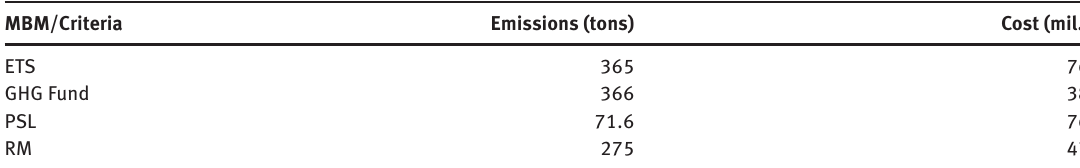
Table 3: Results of the Output Variables after the Defuzzification Process.